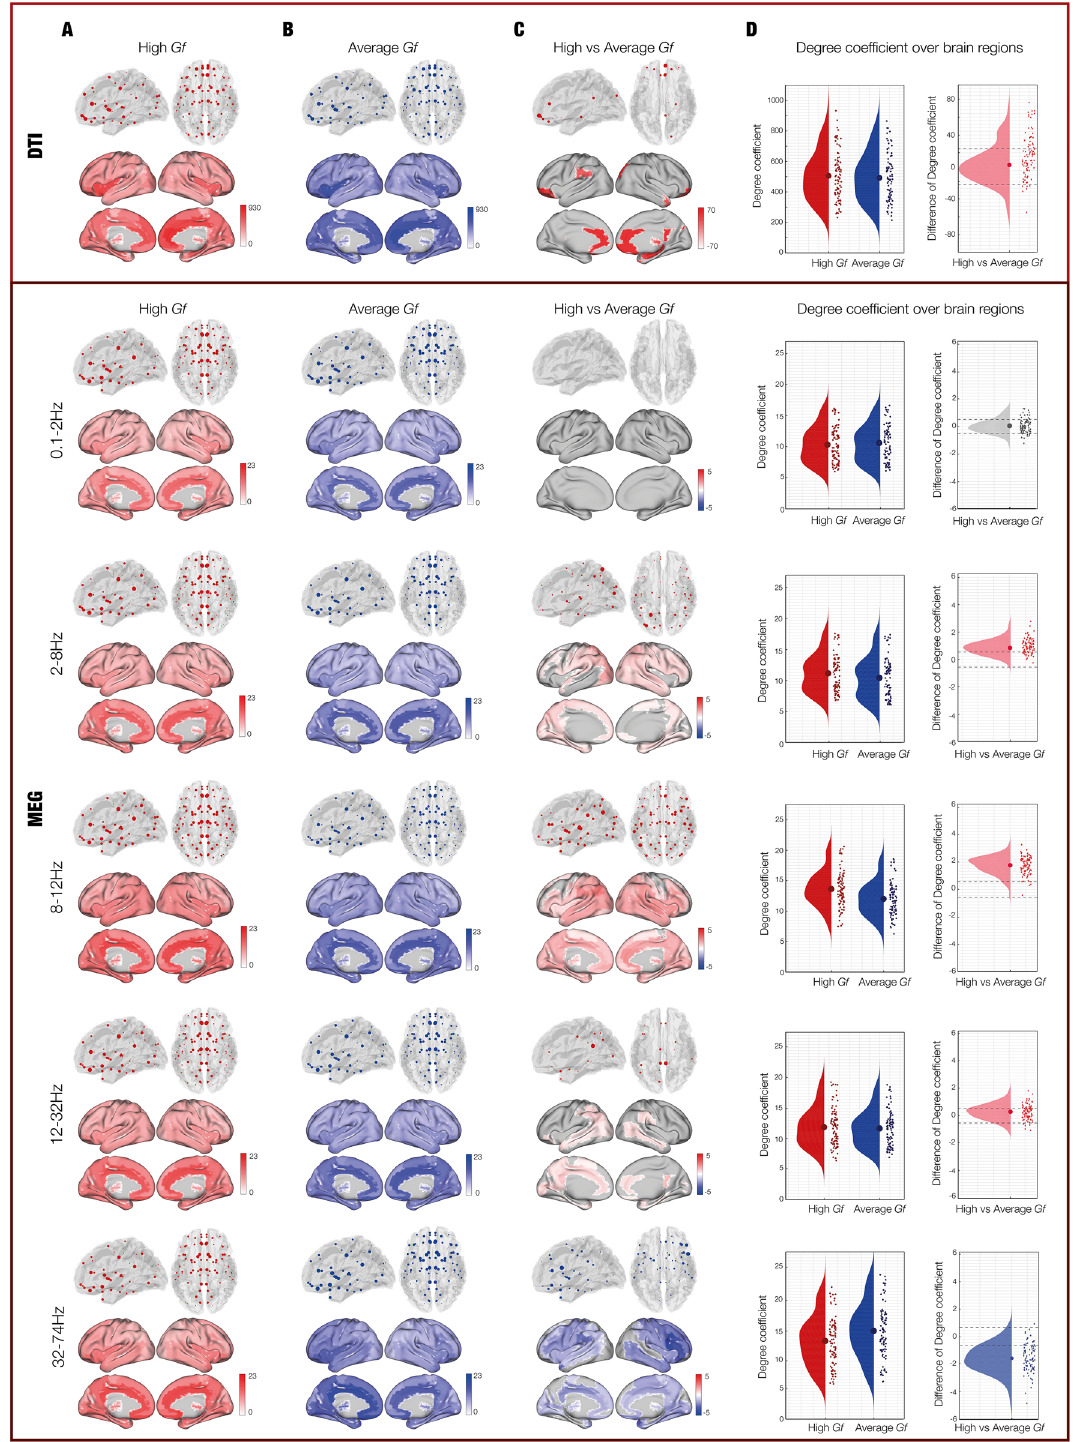
Figure 3. Degree of connectivity. ( A ) Degree coefficients of structural and functional connectivity in participants with high Gf. ( B ) Degree coefficients of structural and functional connectivity in participants with average Gf. ( C ) Contrasts of the degree coefficients between the two groups. In the contrast, the red colour indicates that high Gf individuals had stronger degree among a significantly higher number of ROIs, while blue showed a stronger degree among a significantly higher number of ROIs for average Gf participants. This column illustrates the ROIs whose degree coefficients were stronger than at least one standard deviation above the mean across all ROIs. ( D ) Degree depicted for every brain ROI of high, average and high versus average Gf. Each dot shows the degree of each of the 90 ROIs, independently for high and average Gf participants. Dashed lines indicate the standard deviation with reference to zero, helping to identify whether the ROIs had a stronger or weaker degree for high versus average Gf